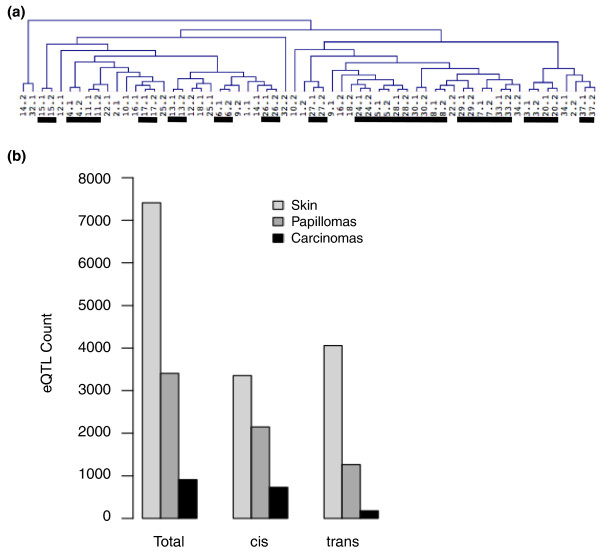
The influence of germline polymorphisms on gene expression is present but reduced in tumors. (a) Hierarchical clustering of total gene expression from papilloma pairs indicates that germline polymorphisms continue to exert a major effect on gene expression at the benign tumor stage. Bars indicate when both papillomas in a pair are most similar to each other. (b) Counts of total, cis-, and trans- eQTL in skin, papillomas, and carcinomas, showing that overall germline control of gene expression is strongly reduced, particularly for trans-eQTL, in malignant carcinomas.